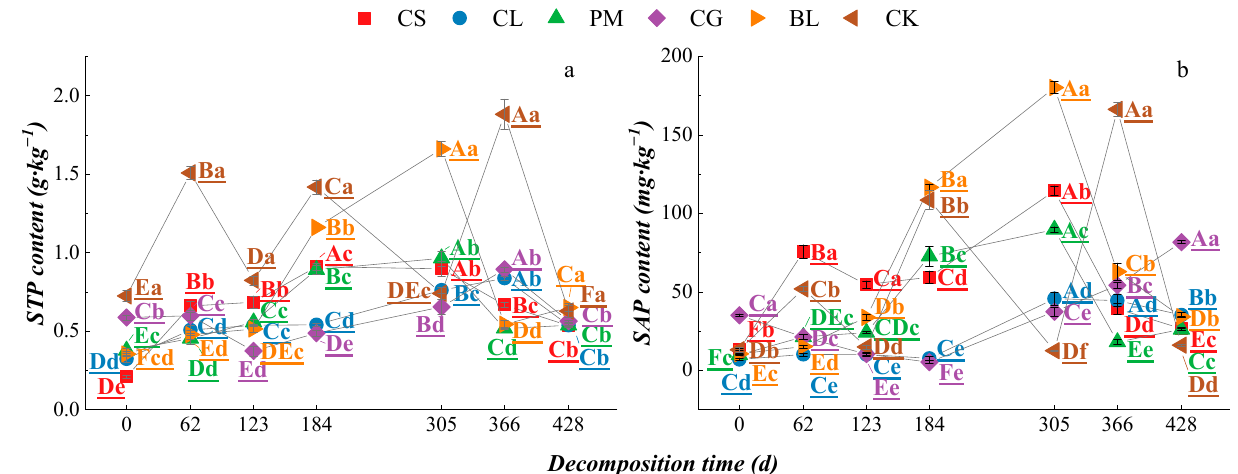
Figure 7. Dynamic changes in soil N content during the litter decomposition process (( a )-STN, ( b )-SAN). CS— Camellia sinensis , CL— Cunninghamia lanceolata , PM— Pinus massoniana , CG— Cinnamomum glanduliferum , BL— Betula luminifera , CK—control; STN—soil total nitrogen, SAN—soil hydrolyzed nitrogen; A, B, C—differences between decomposition stages of the same treatment; a, b, c—differences between treatments in the same decomposition period.